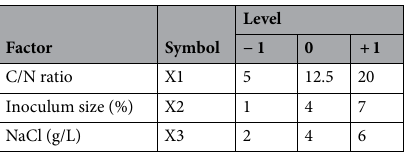
Table 2. Coded level and real values of independent